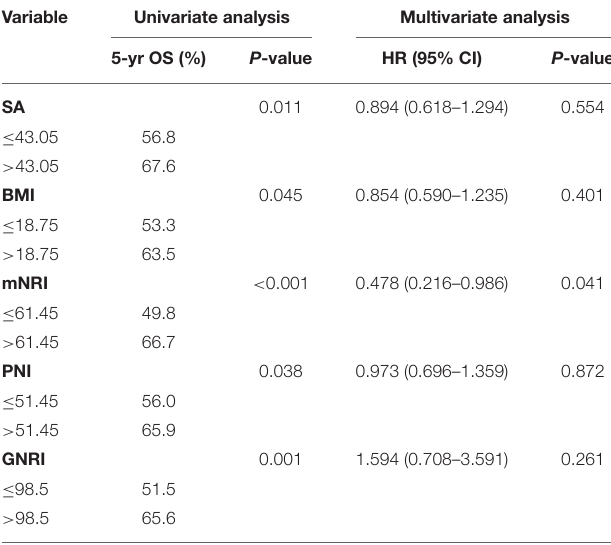
TABLE 3 | Univariate analysis and multivariate analysis in regard to overall survival according to clinicopathological factors. Variable Univariate analysis Multivariate analysis